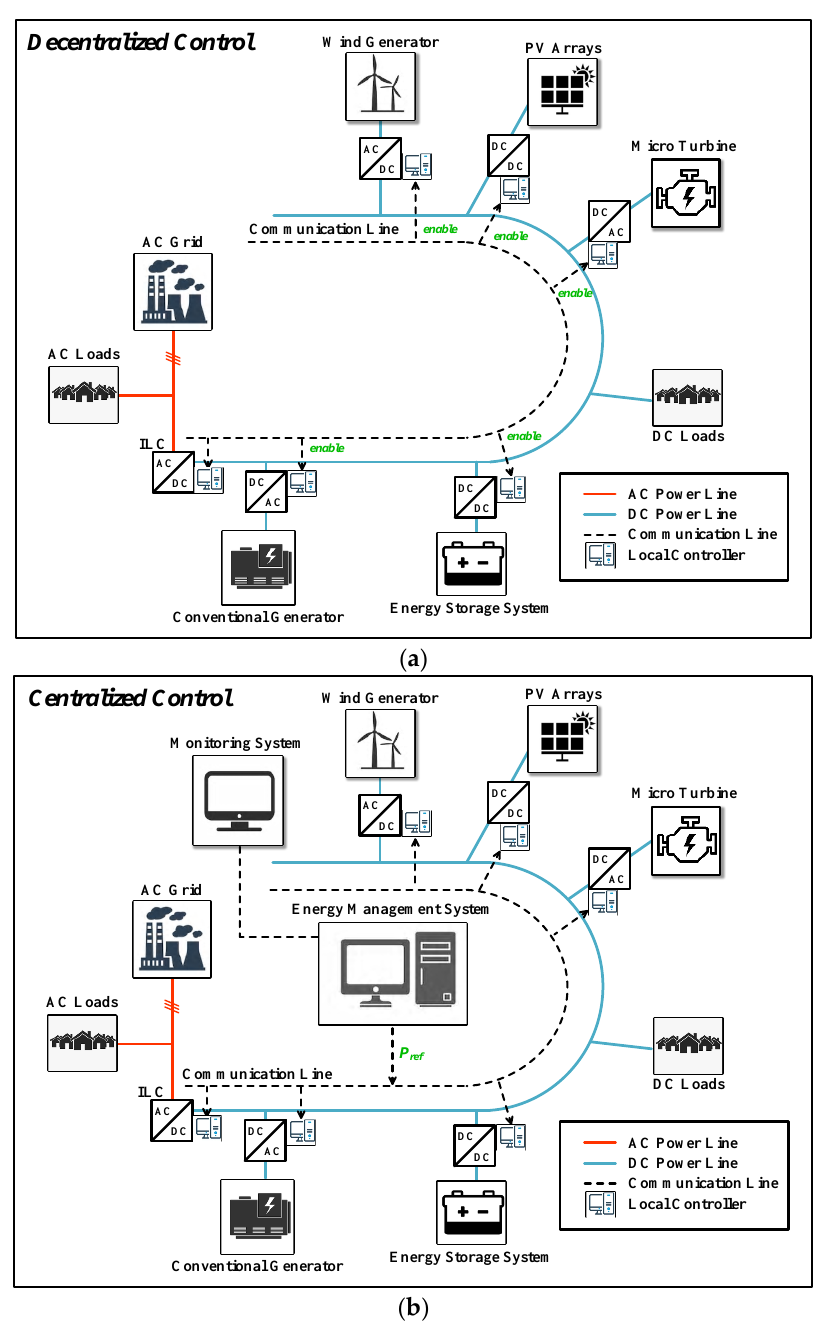
Figure 2. Two types of control structure for EMSs ( a ) decentralized control, ( b ) centralized control